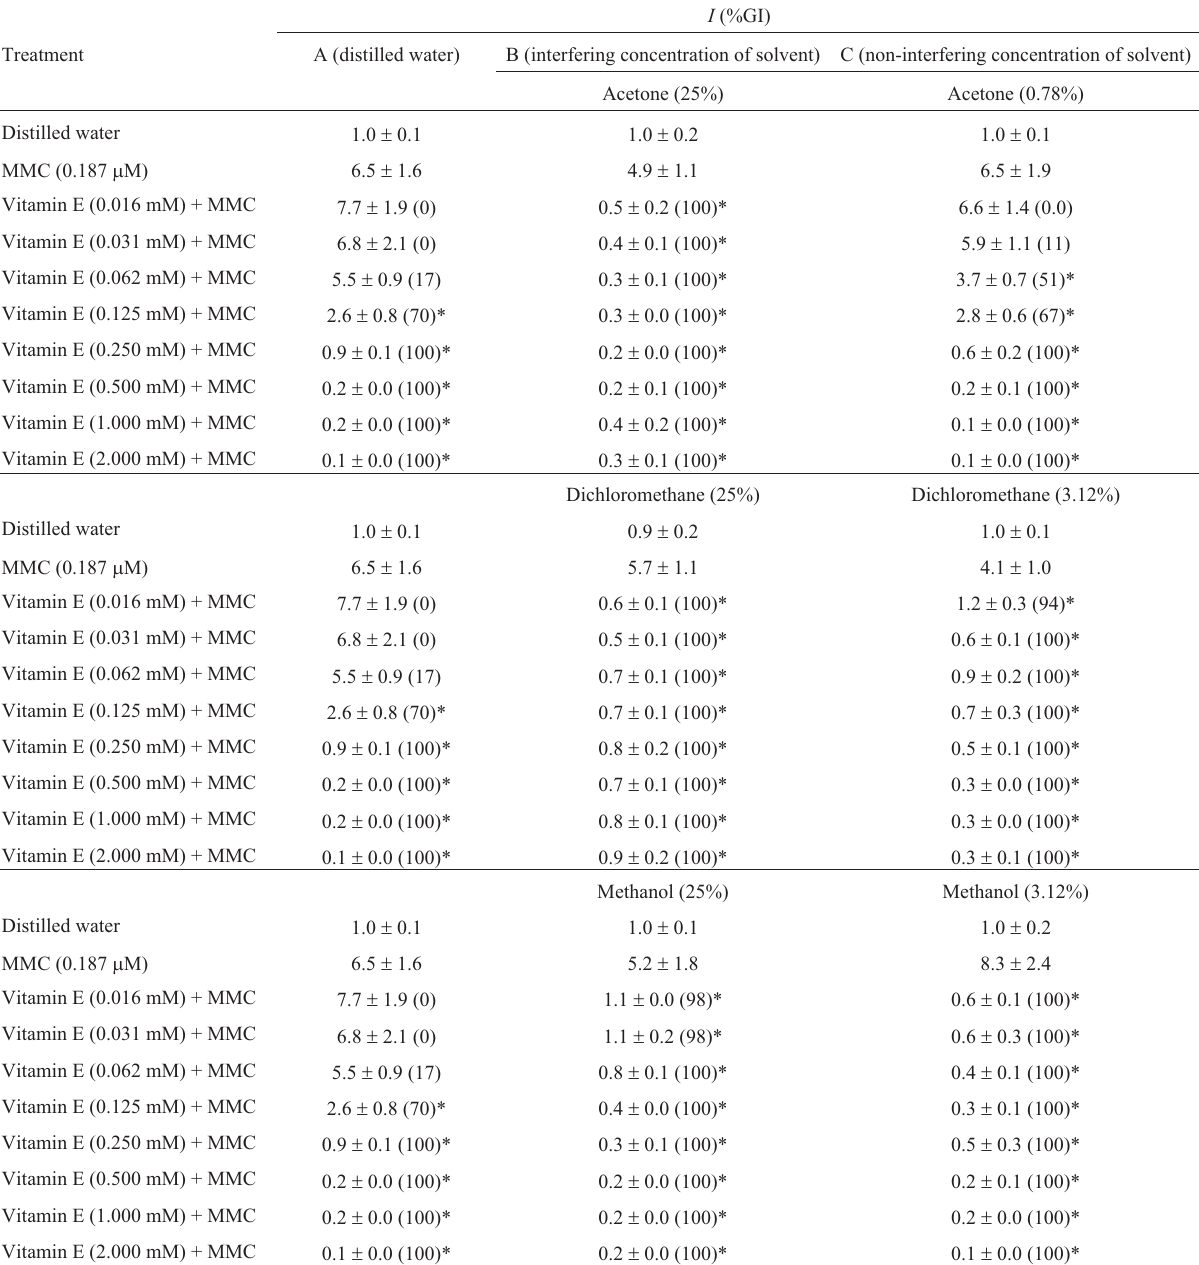
Table 4 - Influence of solvents on vitamin E antigenotoxicity against MMC-induced DNA damage in E. coli PQ37